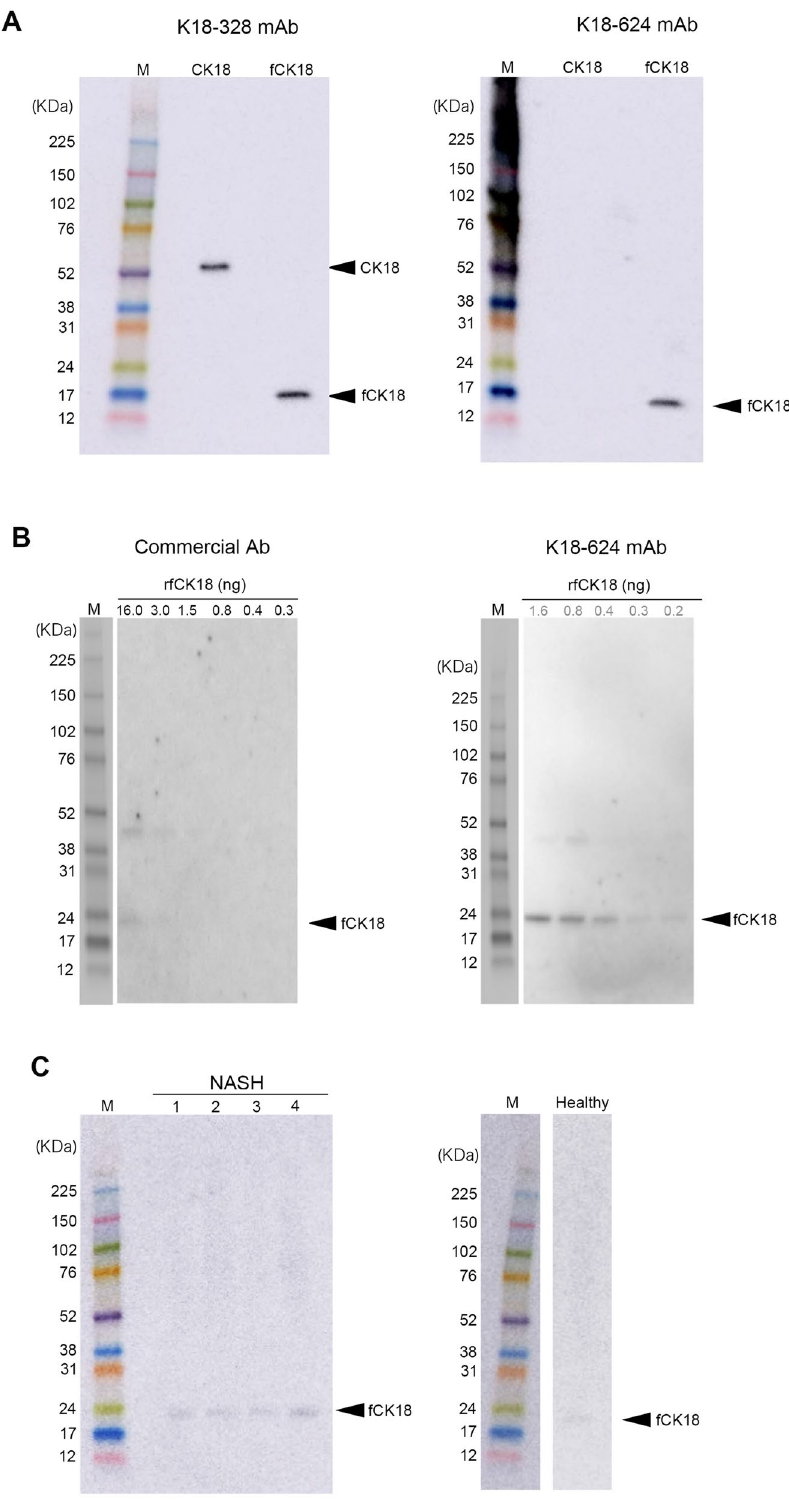
Figure 1. Characterization of antibodies by immunoblotting. ( A ) The detection of full-length CK18 (CK18) and fragmented CK18 (fCK18) with K18-328 antibody (left panel) or K18-624 antibody (right panel) by western blotting (WB). The arrows indicate the band of CK18 or fCK18. ( B ) The reactivity of antibodies, 22.5 ng of commercial (left panel) or 22.5 ng of K18-624 (right panel), to the different concentrations of rfCK18 by Immunoprecipitation-WB. The arrow indicates the band for rfCK18. A faint back between the 38 and 52 kDa marker indicates the band for dimer of rfCK18. ( C ) The detection of fCK18 using the K18-624 antibody and NASH patients or healthy individual by WB. The arrow indicates the band for